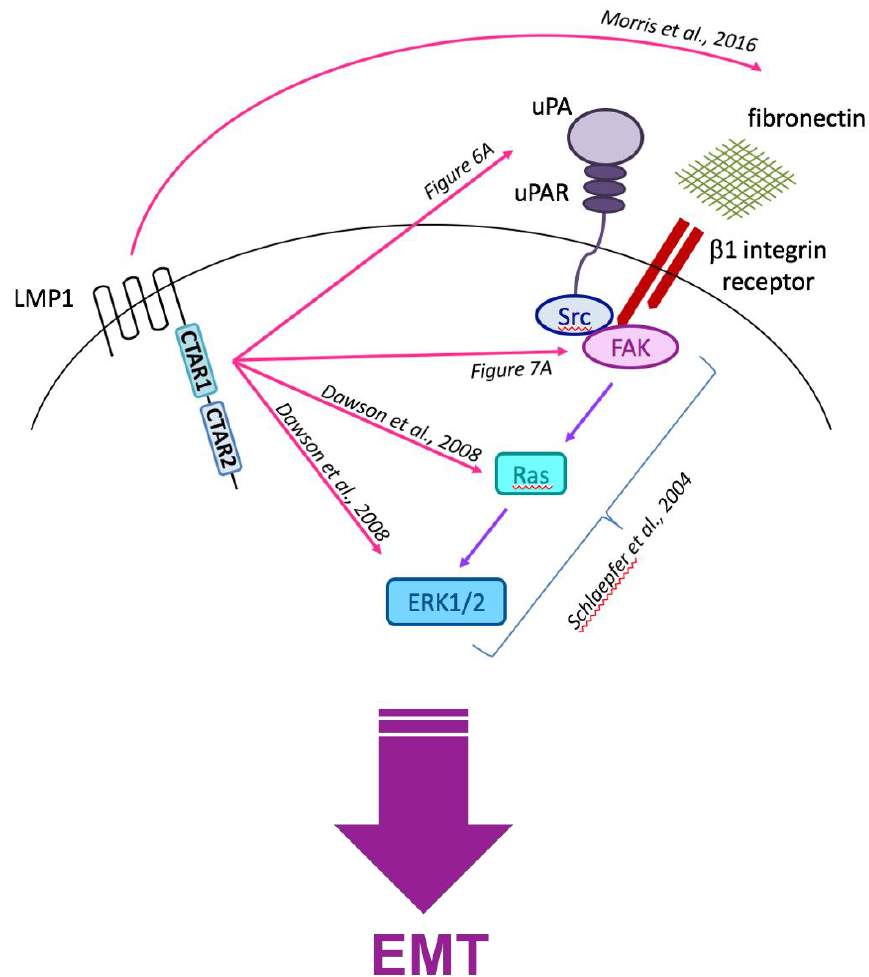
Figure 8. Schematic summarising the current working hypothesis for the LMP1-mediated EMT programme.